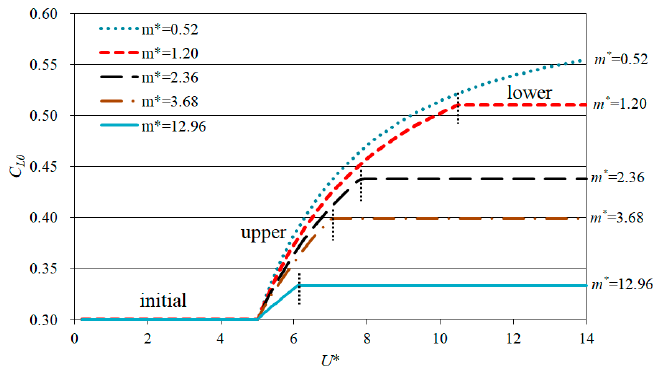
Figure 8. Variation of C L 0 in the modified wake oscillator model versus reduced velocity with different m *.